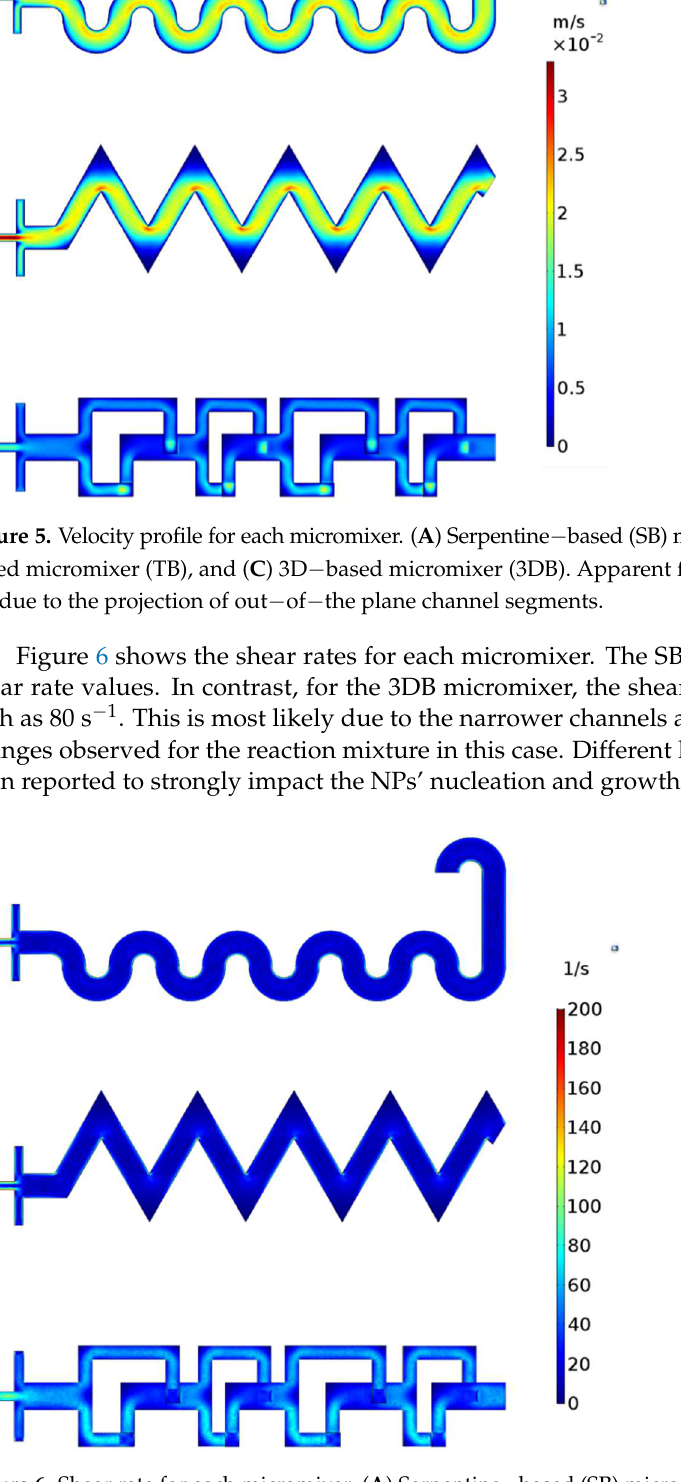
Figure 6. Shear rate for each micromixer. ( A ) Serpentine − based (SB) micromixer, ( B ) Triangula − based (TB) micromixer, and ( C ) 3D − based (3DB) micromixer.